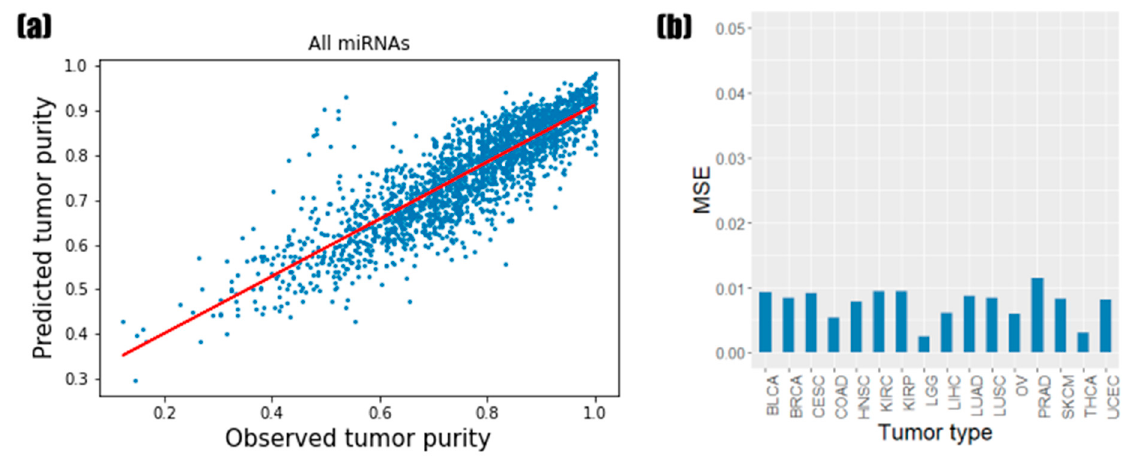
Figure 1. Prediction results of the tumor purity using miRNA expression. ( a ) Scatterplots of tumor purity values across the 16 tumor types of the test samples. The red line is the regression line. ( b ) Bar plots of the test mean square error (MSE) value for each tumor type.